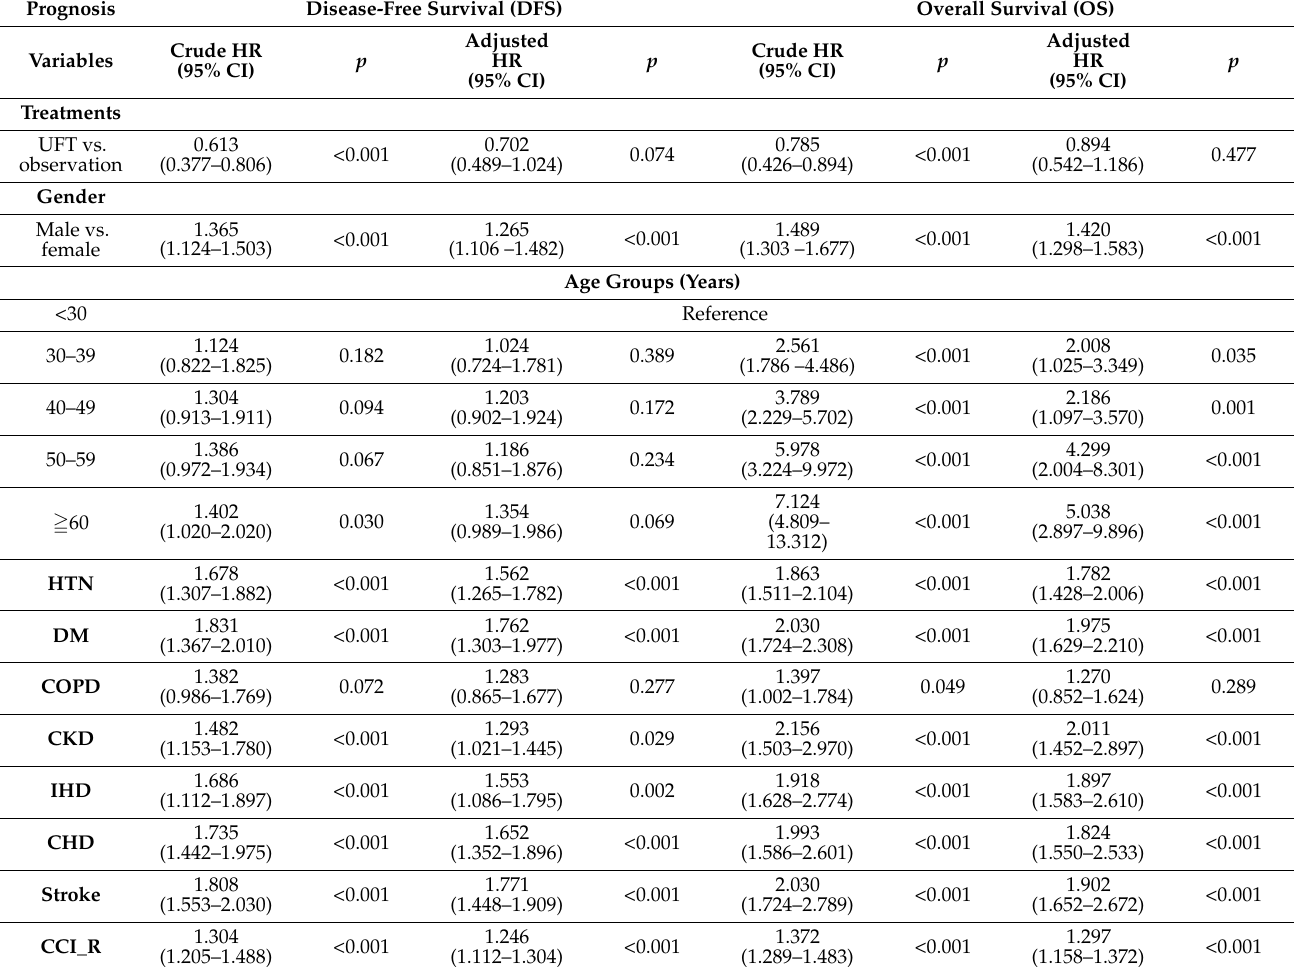
Table 2. Cox regression analysis of disease-free survival and overall survival.